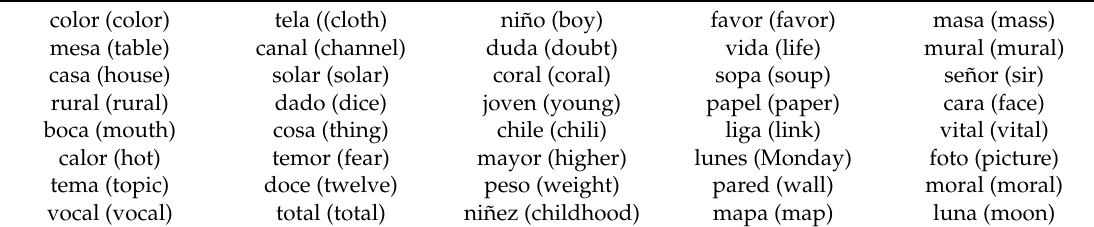
Table A1. Stress Assignment Task.